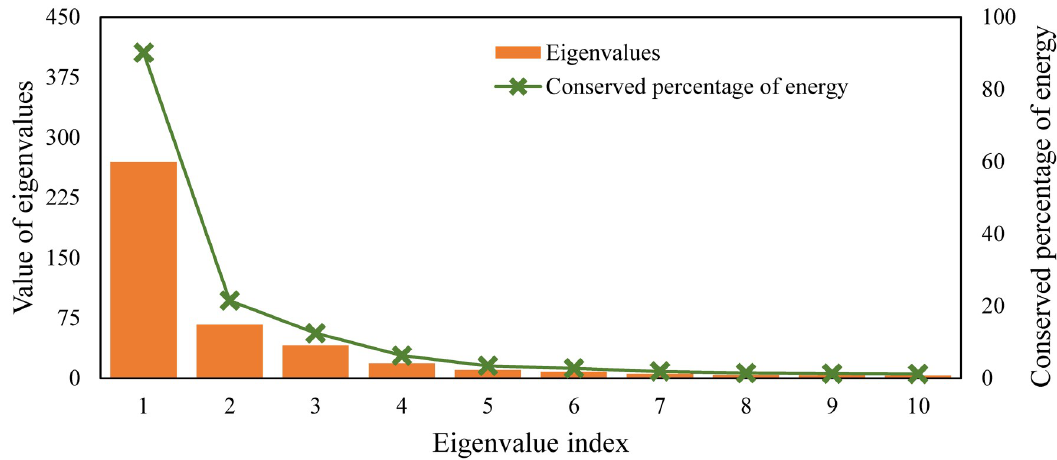
Fig 5. The first 10 calculated eigenvalues and their conserved energy percentage in the Persian Gulf & Gulf of Oman (PG&GO).